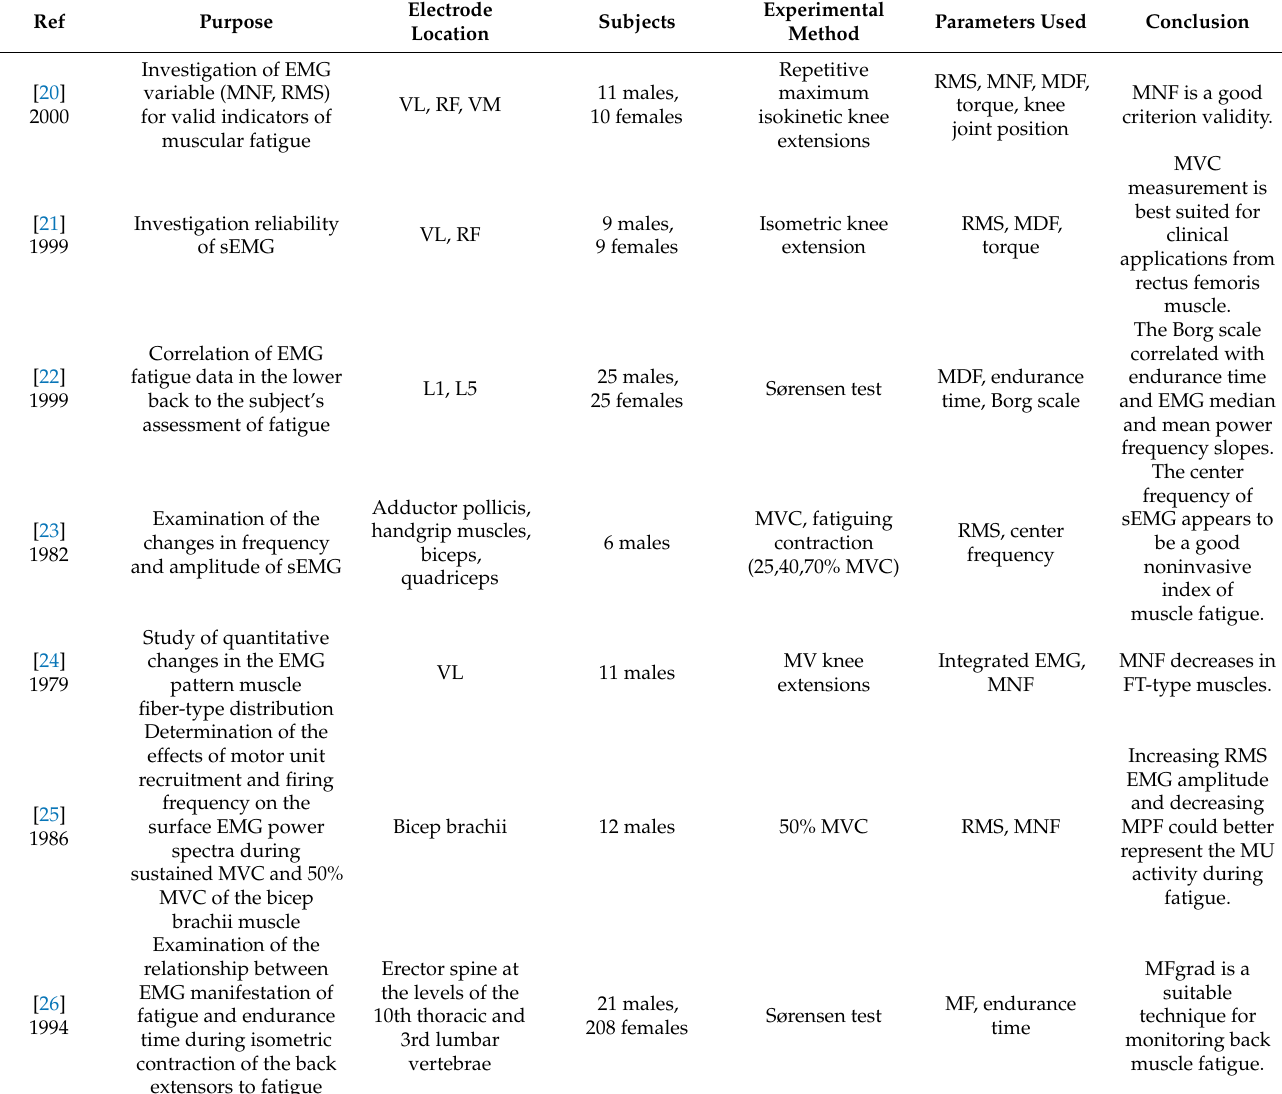
Table 1. Reliability of EMG parameters for fatigue